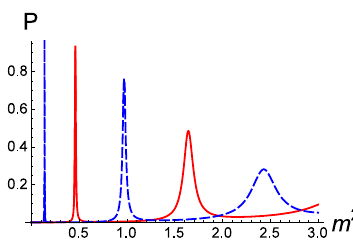
Figure 2. The relative probability P ( m 2 ) of the even parity mode t e (red solid lines) and the odd parity mode t o ( z ) (blue dashed lines) for the single brane model (3.1). The parameters are set to k = 1 and b =